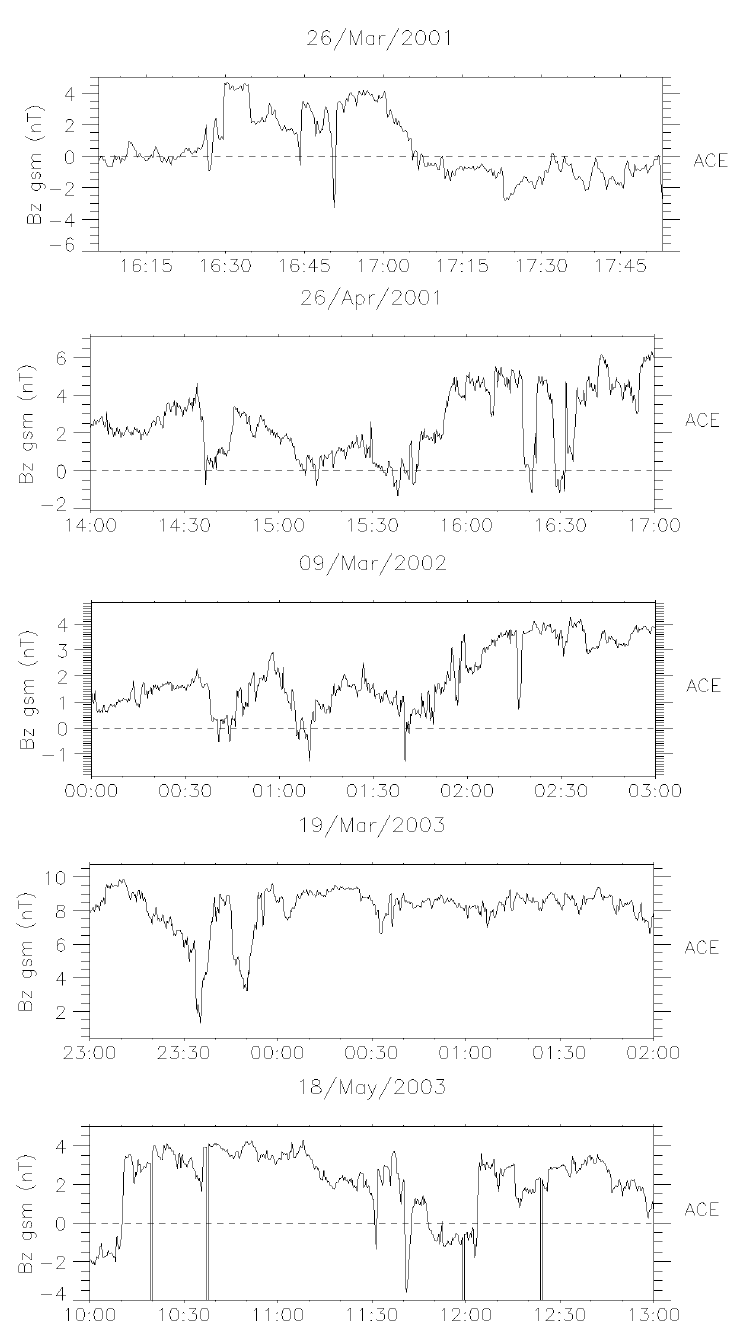
Fig. 10. The solar wind IMF B z component from the ACE spacecraft during typical polar cap crossings when Cluster encountered ionospheric ion